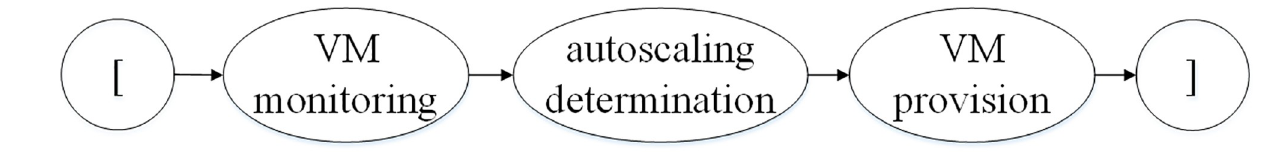
Fig 14. ESG of an elastic cloud management